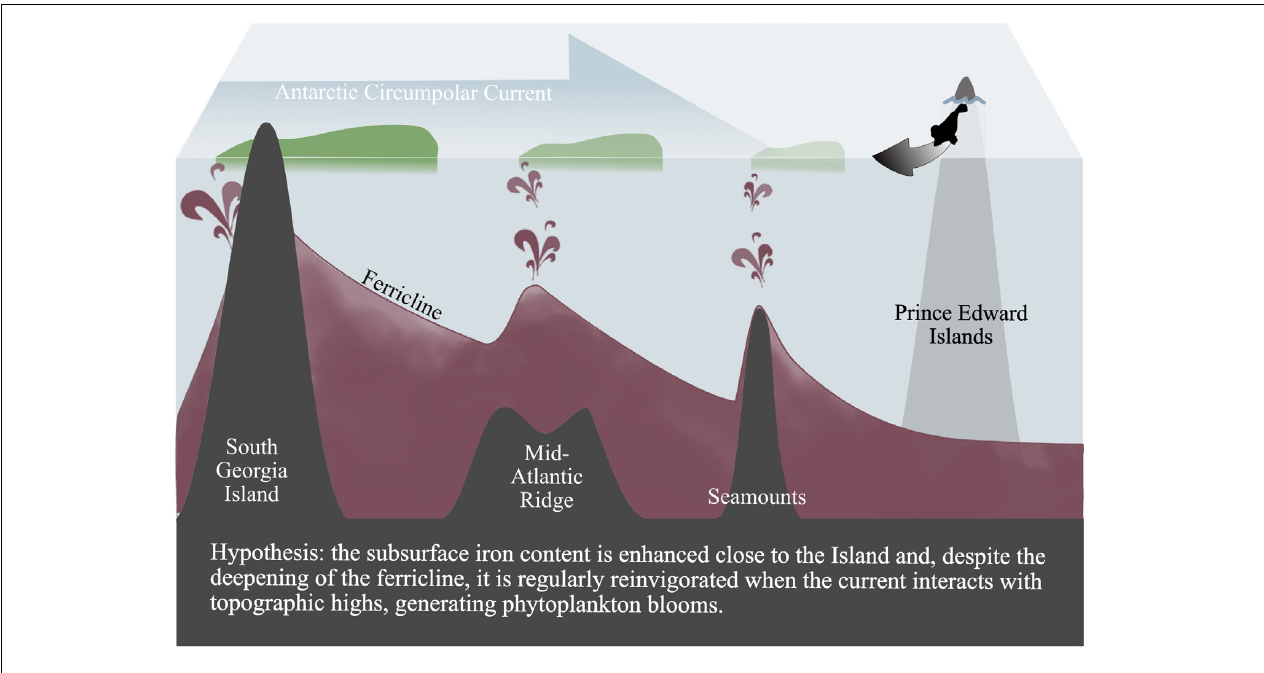
FIGURE 7 | Schematic summarizing of phytoplankton productivity in the Atlantic ACC region. The interaction of the ACC with topographic highs generates upward movements and facilitates the injection of iron in the euphotic layer (symbolized by the burgundy-colored jets). Lightening of the phytoplankton blooms (green) is an indication of the decreasing of the Chl a concentration. Subantarctic pinnipeds and penguins from Prince Edward Islands (symbolized by the gray arrow) are foraging on this complex biological